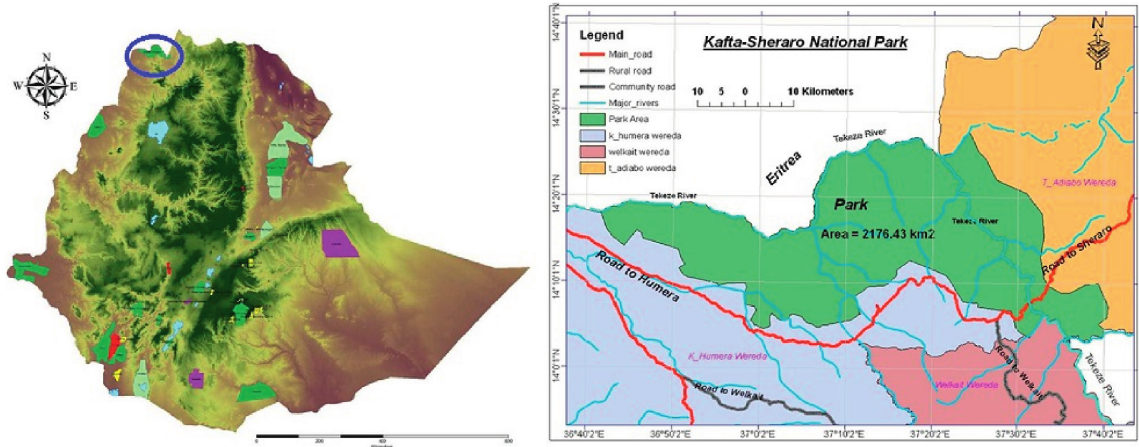
Figure 1: Map showing the location of Kafta Sheraro National